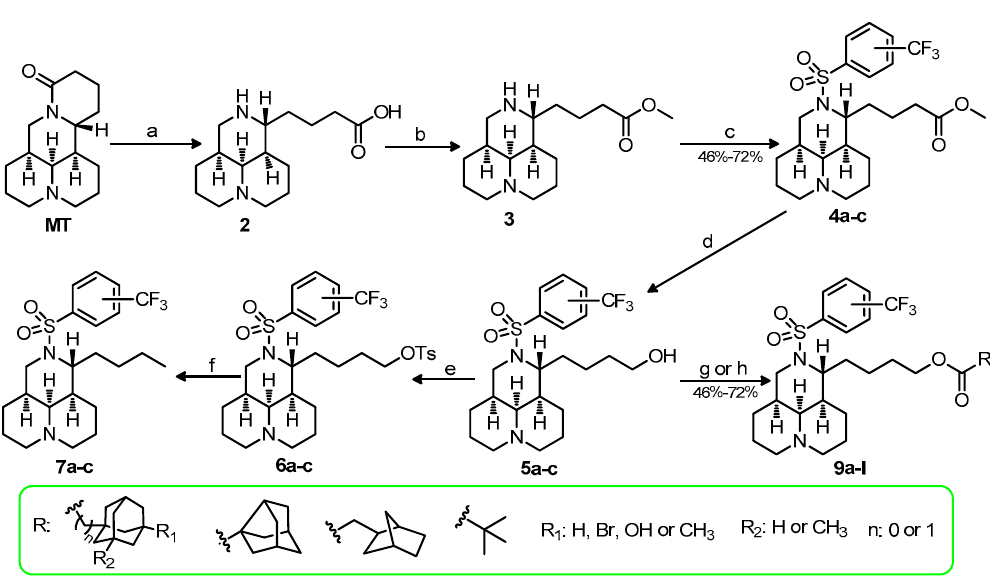
Table 1. Anti-H3N2 activities of all title compounds and anti-H1N1 activities of key compounds.